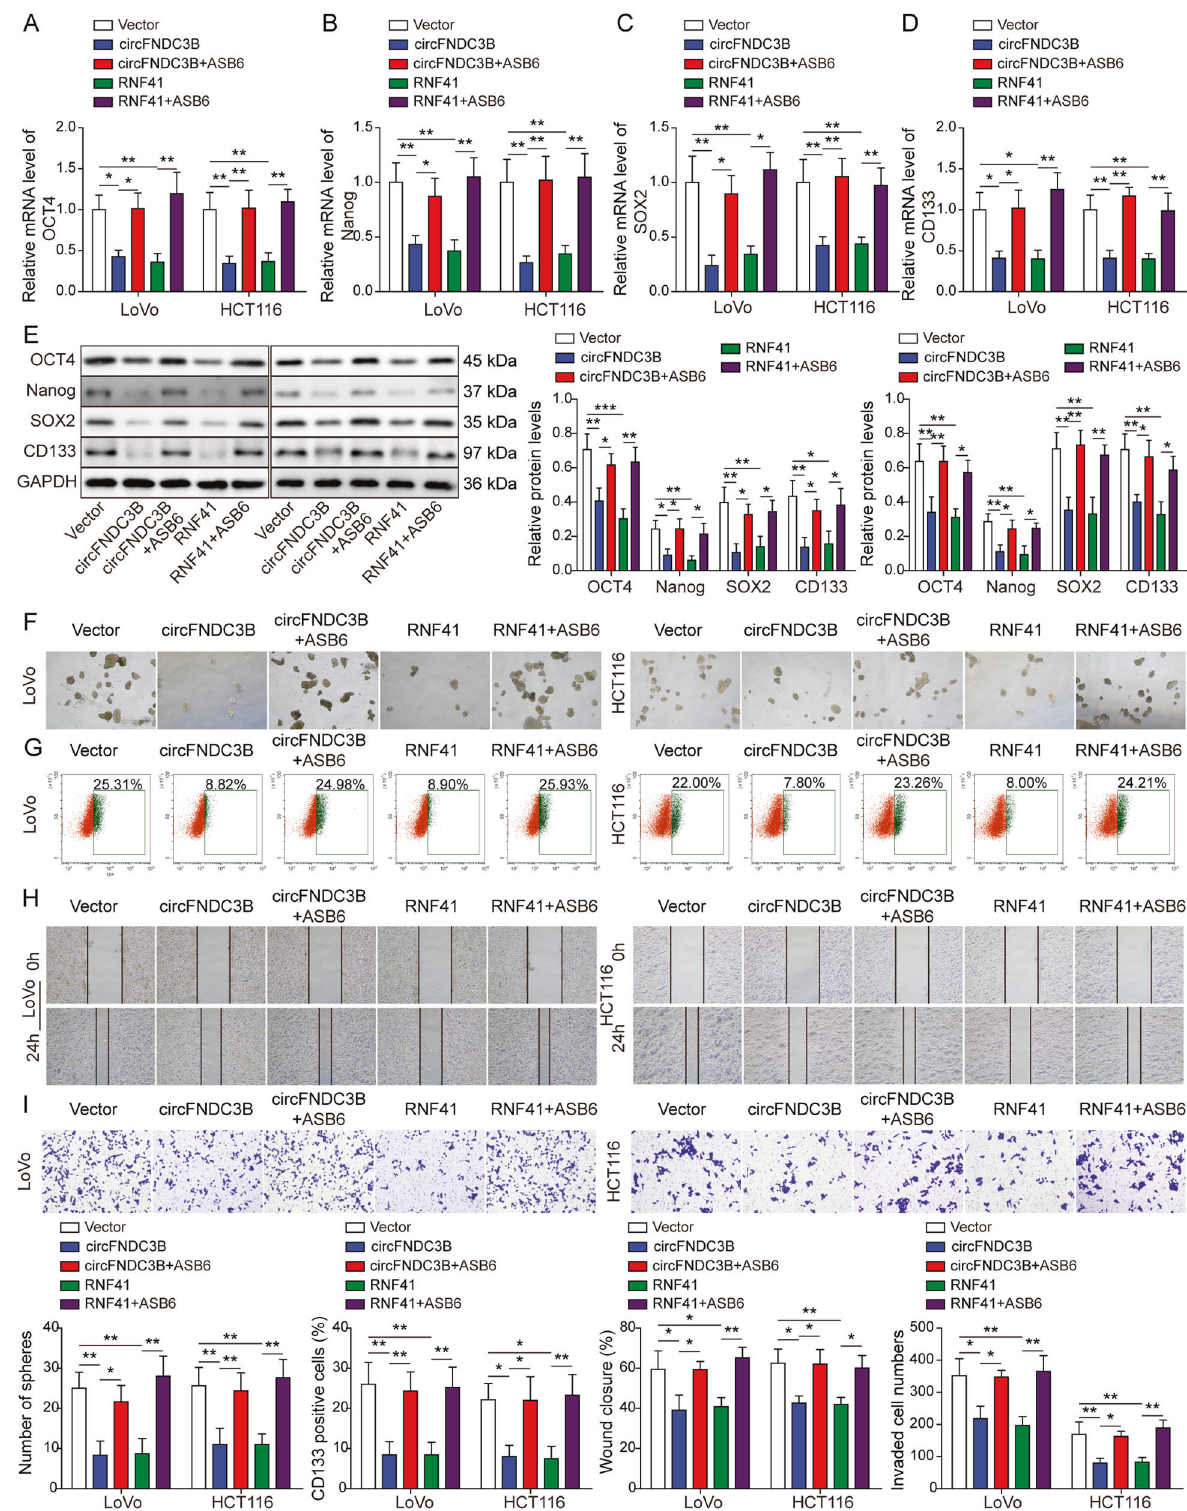
Fig. 8 Overexpression of ASB6 reverses circFNDC3B or RNF41-mediated regulation of CRC stemness and metastasis. A – E The expression of stemness markers were detected by qRT-PCR and western blotting. F Representative sphere images of transfected CRC cells with quantitative analysis. G CD133 + cells were analyzed by fl ow cytometry with quantitative analysis in transfected CRC cells. H Cell migration was monitored by wound healing assay with quantitative analysis in transfected CRC cells. I Cell invasion was measured by Transwell invasion assay with quantitative analysis. * P < 0.05, ** P <